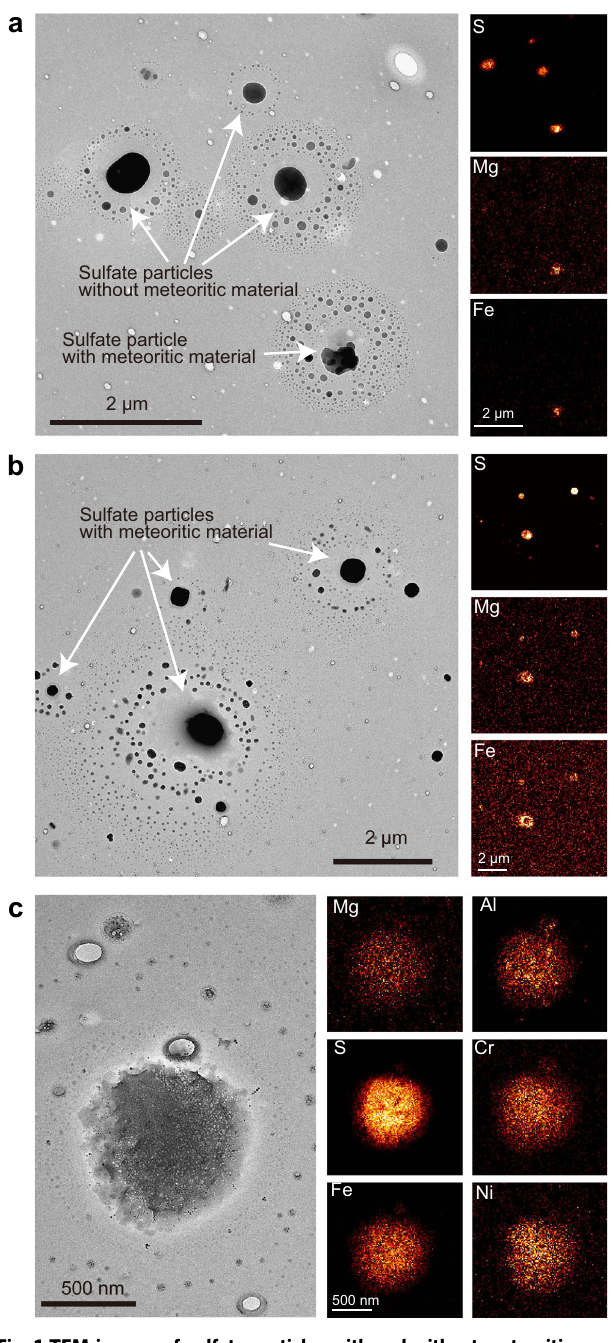
Fig. 1 TEM images of sulfate particles with and without meteoritic material and the corresponding elemental maps. Sulfate particles containing meteoritic material have S, Mg, and Fe, as well as Al, Cr, and Ni (particle c). These sulfate particles are surrounded by satellite structures, indicating that they were less neutralized and had a low viscosity when collected. Although these particles are mixtures of various elements, they were de fi ned as sulfate based on (1) the abundance of S, (2) the round shapes and crystal structures, and (3) the beam sensitivity, all of which are consistent with sulfate particle properties reported in previous studies 53, 54 . The TEM samples were collected on a 5:21 UTC, July 17, 2013, b 5:24 UTC, July 18, 2013, and